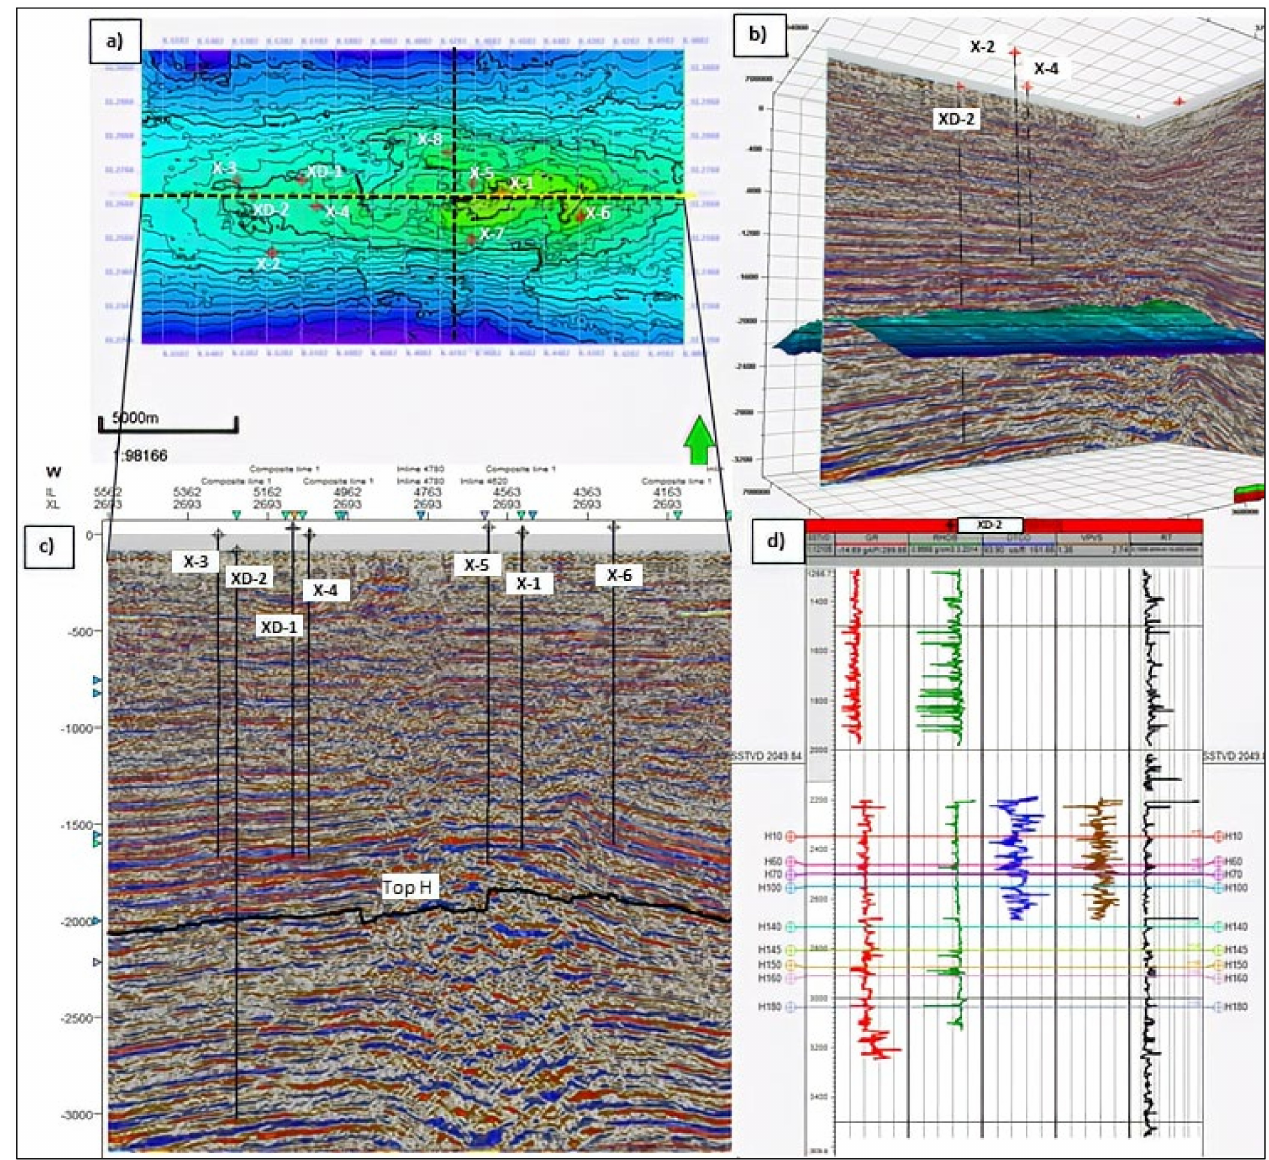
Figure 4. ( a ) Map of seismic geometry with well locations; ( b ) Interpreted horizon Top H and well locations; ( c ) Migrated seismic section view; ( d ) Logging profile of XD-2